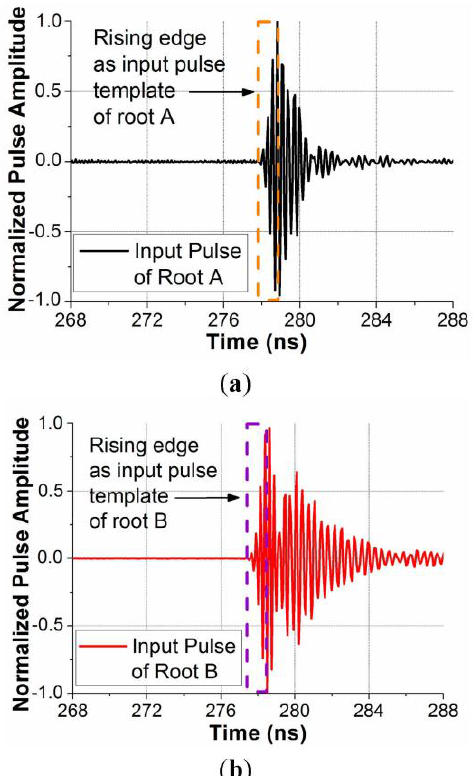
Figure 5. Normalized input (or transmitted) pulse waveforms obtained by the back to back measurements for ( a ) the root antenna A and ( b ) the root antenna